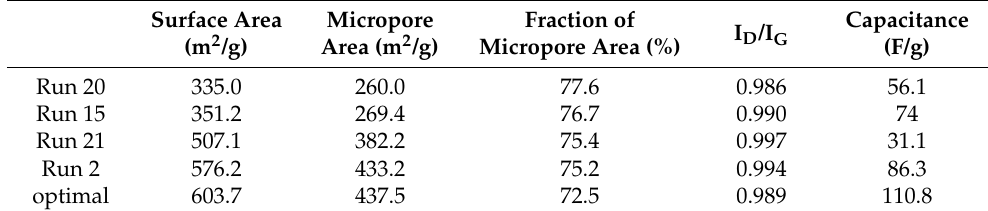
Table 7. Properties of the as-obtained activated carbon.